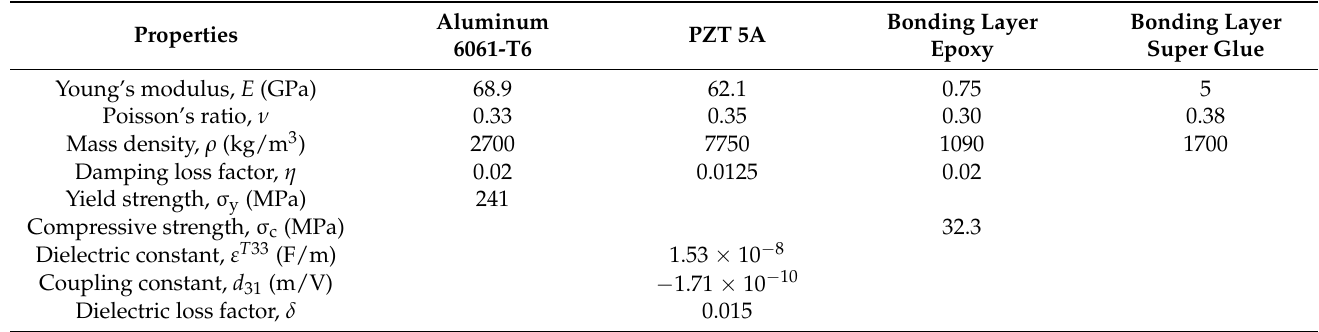
Table 1. Material properties of aluminum, bonding layer, and PZT patch.